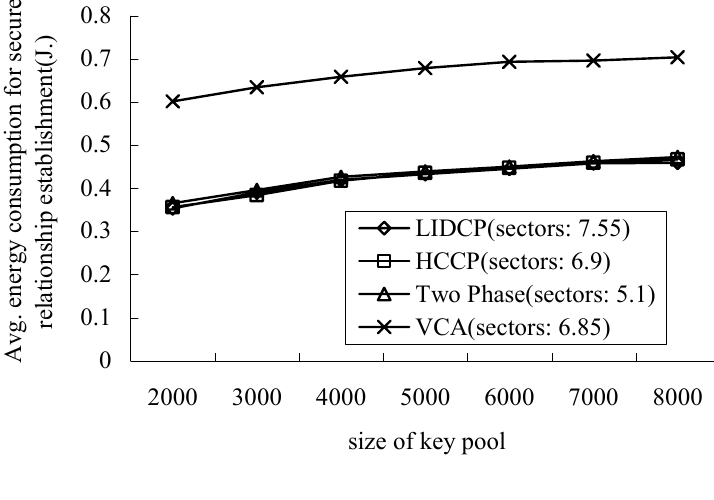
Figure 3. Energy consumption for intra-sector key establishments vs. size of key